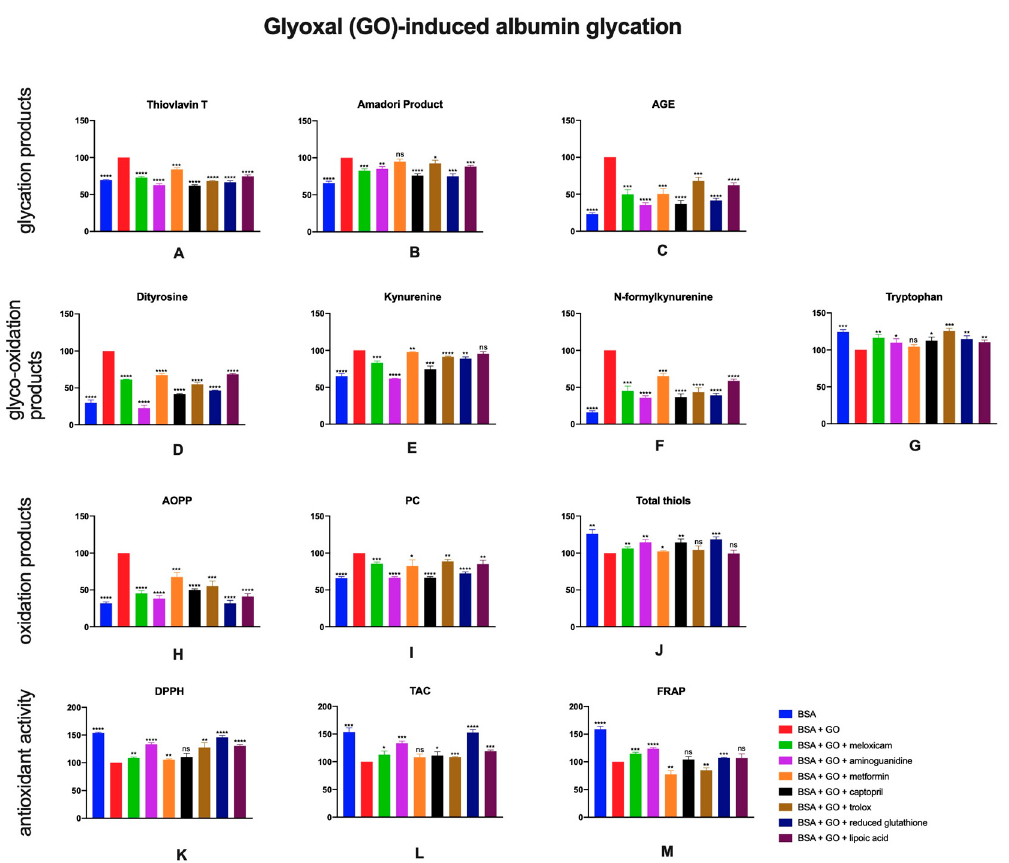
Figure 5. The effects of meloxicam, captopril, trolox, reduced glutathione, lipoic acid, aminoguanidine or metformin addition to BSA + glyoxal solution on protein glycation ( A – C ), glycooxidation ( D – G ) and oxidative damage ( H – J ) as well as total antioxidant potential ( K – M ). AGE: advanced glycation end products; AOPP: advanced oxidation protein products; BSA: bovine serum albumin; DPPH: 2,2-di-phenyl-1-picrylhydrazyl radical scavenging capacity; FRAP: ferric reducing antioxidant power; GO: glyoxal; PC: protein carbonyls; TAC: total antioxidant capacity; ns: not significant vs. control; * p < 0.05 vs. control; ** p < 0.01 vs. control; *** p < 0.001 vs. control; **** p < 0.0001 vs.